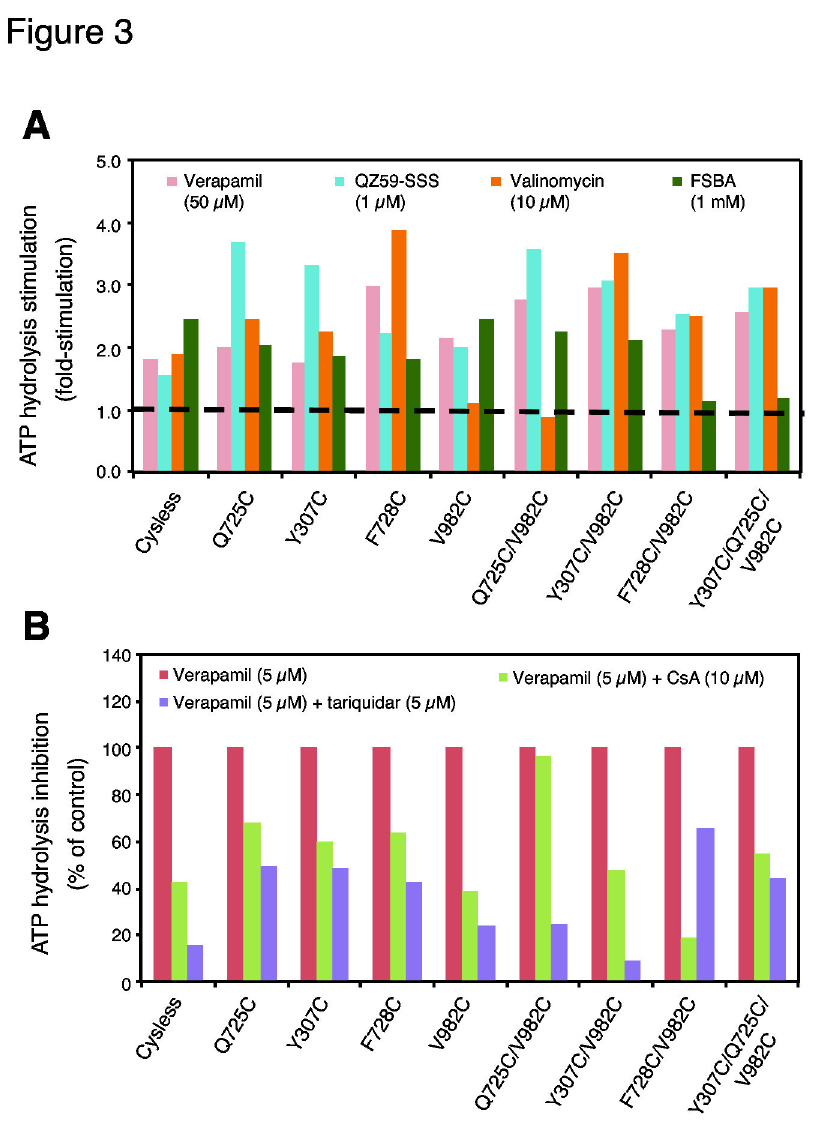
Figure 3. Modulation of ATP hydrolysis by drugs is retained by mutant Pgps. (A) Stimulation of ATP hydrolysis by verapamil (50 µM), QZ59- SSS (1 µM), valinomycin (10 µM) and FSBA (1 mM) are shown in bar graph format; basal activity (in the absence of added drug) indicated by dashed line is equal to one. (B) Inhibition of verapamil-stimulated ATP hydrolysis by CsA (10 µM) and tariquidar (5 µM) is shown. The ATPase activity is measured in the presence of verapamil (5 µM) because of the low basal activity of most of the mutants; the first bar thus indicates the activity in the presence of 5 µM verapamil, which is taken as 100% (control). Vanadate-sensitive Pgp-mediated ATP hydrolysis was measured as described in Materials and Methods. In the case of FSBA, 5 mM ATP was added prior to the addition of FSBA [21]. At least two independent experiments were carried out for each mutant with indicated compounds. Additional information including standard deviations, fold-stimulation or % inhibition, and number of experiments is given in the section (Tables S2 and